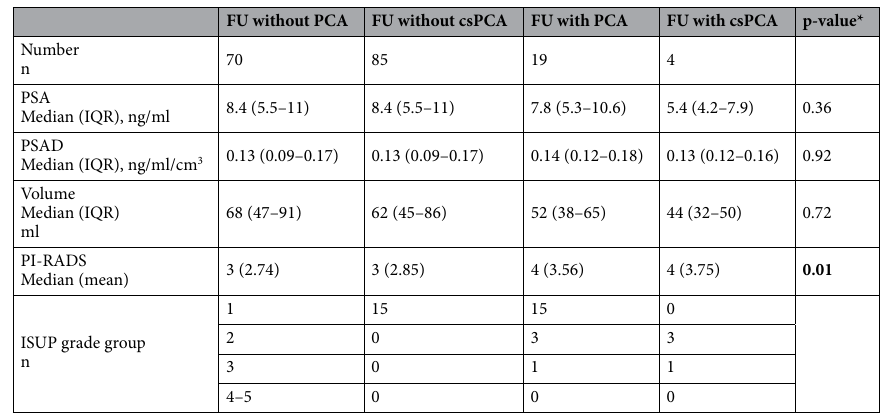
Table 2. Comparison of patients without and with PCA/csPCA. FU: follow up; PCA: prostate cancer; csPCA: clinically significant prostate cancer; PSA: prostate specific antigen; PSAD: prostate specific antigen density; PI-RADS: Prostate Imaging Reporting and Data System; ISUP: International Society of Urological Pathology; IQR: interquartile range; n: number. *Wilcoxon signed rank test. Significant values are given in bold.